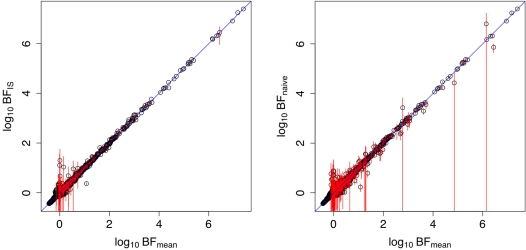
Graphs showing correspondence of BFmean (x-axis) vs BFIS (y-axis on left panel) and BFnaive (y-axis on right panel).In each case the diagonal blue line is y = x, and the vertical red lines indicate ±2 standard errors of the Bayes factor estimate (for example, on the left they run between log10(BFIS±2 standard errors)).